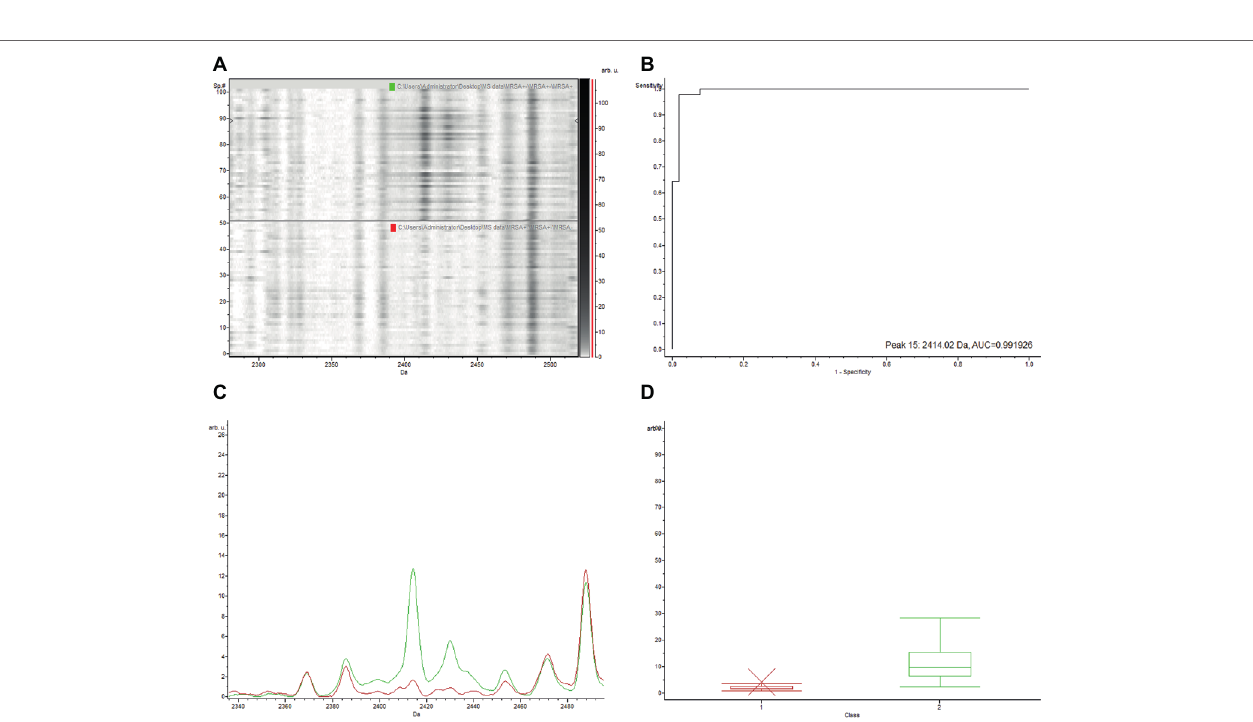
FIGURE 2 | Discrepancy of the characteristic 2,413 m/z peak between PSM-MRSA and MRSA( − ) classification models. MRSA( − ) represents for MRSA isolates without the specific PSM-mec peak. (A) The gel view of the respective section. The red arrow indicates the characteristic peak of 2,413 m/z. Intensities of peaks were expressed in arbitrary units (arb.u.). (B) The AUC of the 2,413 m/z peak. (C) Average spectra of 2,413 m/z peak. Green line and red line represent for PSM-MRSA and MRSA( − ) group, respectively. (D) Display of single peak variance of 2,413 m/z.